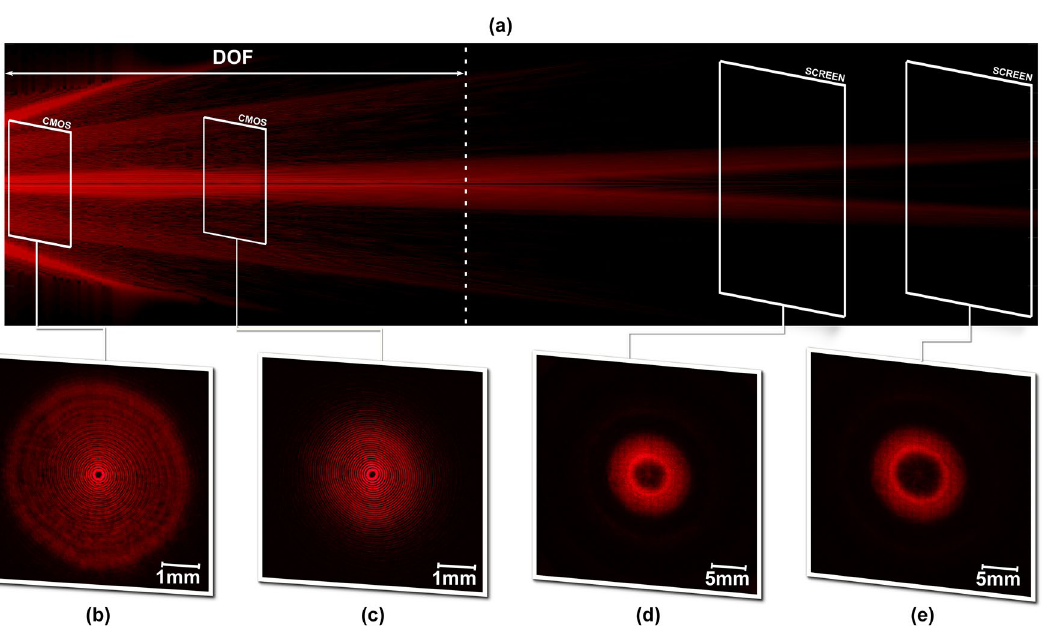
Figure 5. Beam evolution for a convergent DSA with l = 6. ( a ) Simulated beam propagation along 150 cm. ( b – e ) Intensity patterns experimentally measured at z = 25 cm, 50 cm, 125 cm and 150 cm, respectively. ( b – c ). The resultant pattern has been projected directly onto the CMOS sensor. ( d – e ). The resultant pattern has been projected onto an opaque millimeter screen. The intensity has been individually normalized in each measurement